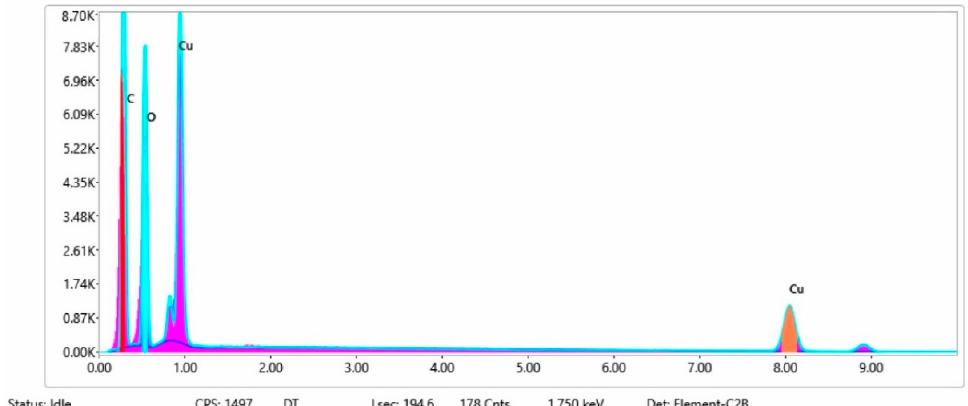
Figure 7. Smart elemental mapping overlay for sample 3: ( a ) untreated with artificial perspiration; ( b ) treated with acid perspiration; ( c ) treated with alkaline artificial perspiration.